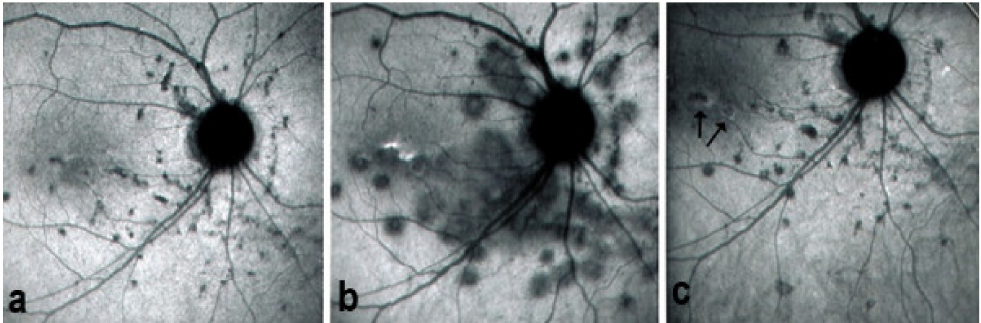
Figure 14. MFC. ICGA time sequence. ( a ): shows quiet stage. Middle picture ( b ) shows reactivation of MFC eight months later. ( c ): shows healed stage of choriocapillaritis six months later after systemic corticosteroid